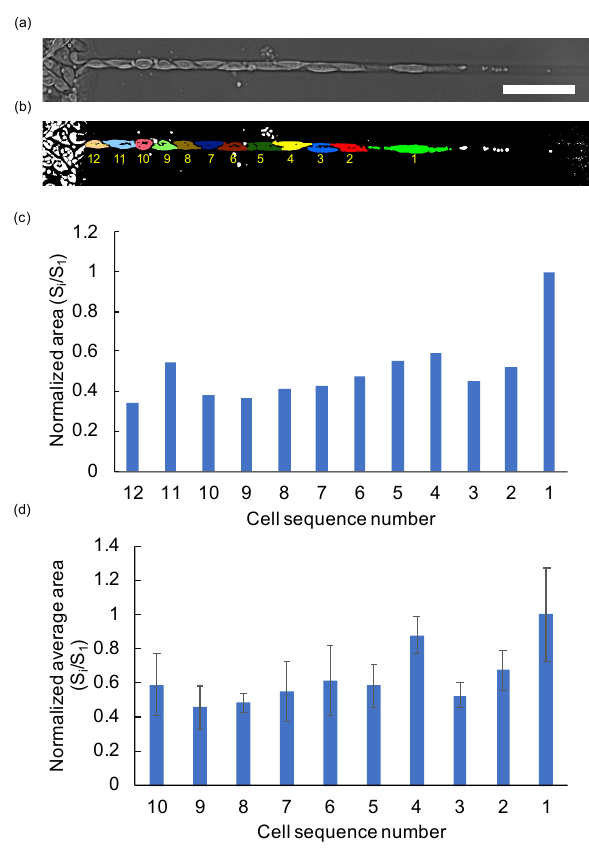
Figure 6. Distribution of aligned single cells in a 10µm microchannel. ( a ) Micrograph image of collective cell migration in 10µm microchannel. Bar: 100µm. ( b ) Binarized image of single cells of ( a ). Each color and the number represents a single cell. ( c ) Normalized area distribution of cells of ( a ). ( d ) Normalized average area distribution of cells in 10µm microchannels ( n = 3). (Bars: mean length of cells; error bars: S.D. of